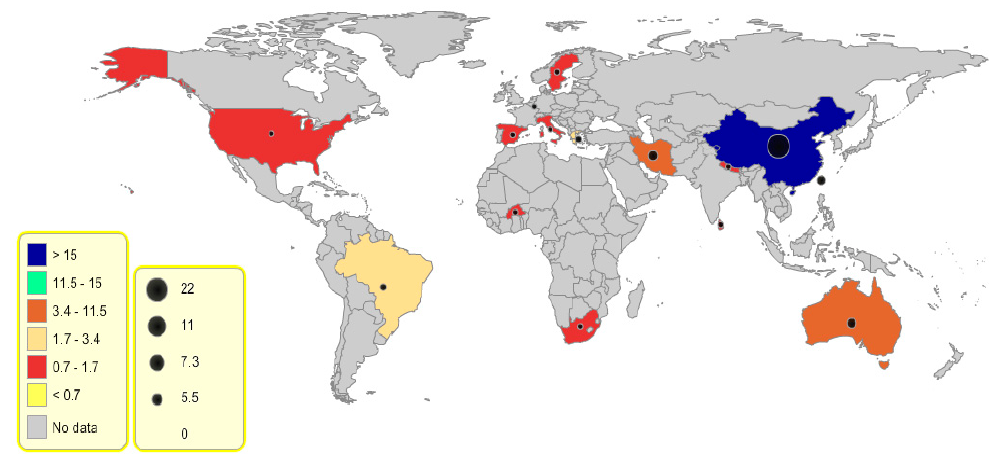
Figure 4. Distribution of publications based on the study region (2000–2018). The color legend shows the range of the number of publications where the dot legend represents the exact number of publications.